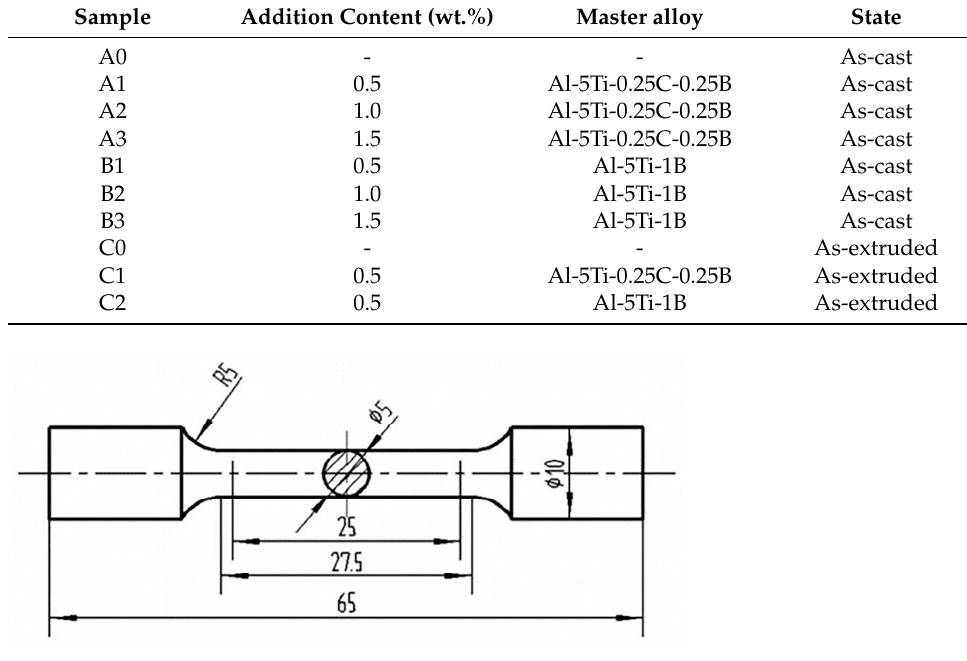
Figure 1. Schematic diagram of tensile rod at room